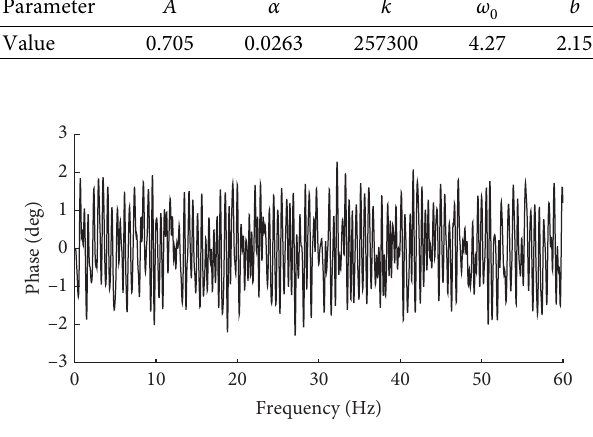
Figure 5: Phase spectrum of EL-Centro wave.